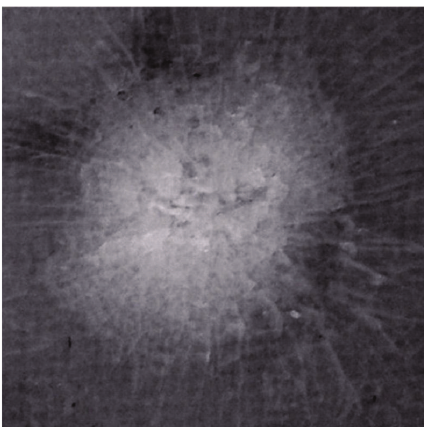
Figure4:Cracksofsamplematrixattheplaceofhittingafterimpact loading.